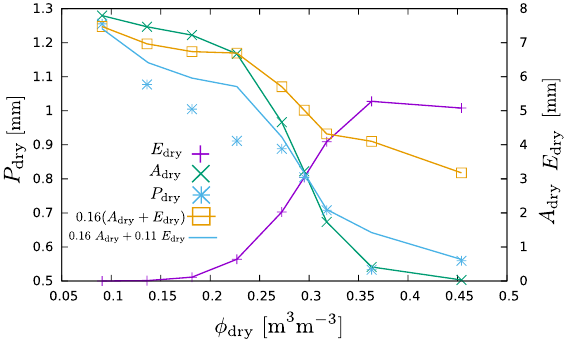
Figure 6. Values of advection (green line and crosses), evapo- ration (purple line and plus symbols) and precipitation (blue as- terisks) from Table 2 as a function of soil moisture. The or- ange line represents an estimate of precipitation obtained as a sum of advection and evaporation weighted by the same effi- ciency, i.e., 0.16 ( A dry + E dry ), while the blue line represents a similar estimate obtained by using two different efficiencies, i.e., 0.16 A dry + 0.11 E dry .